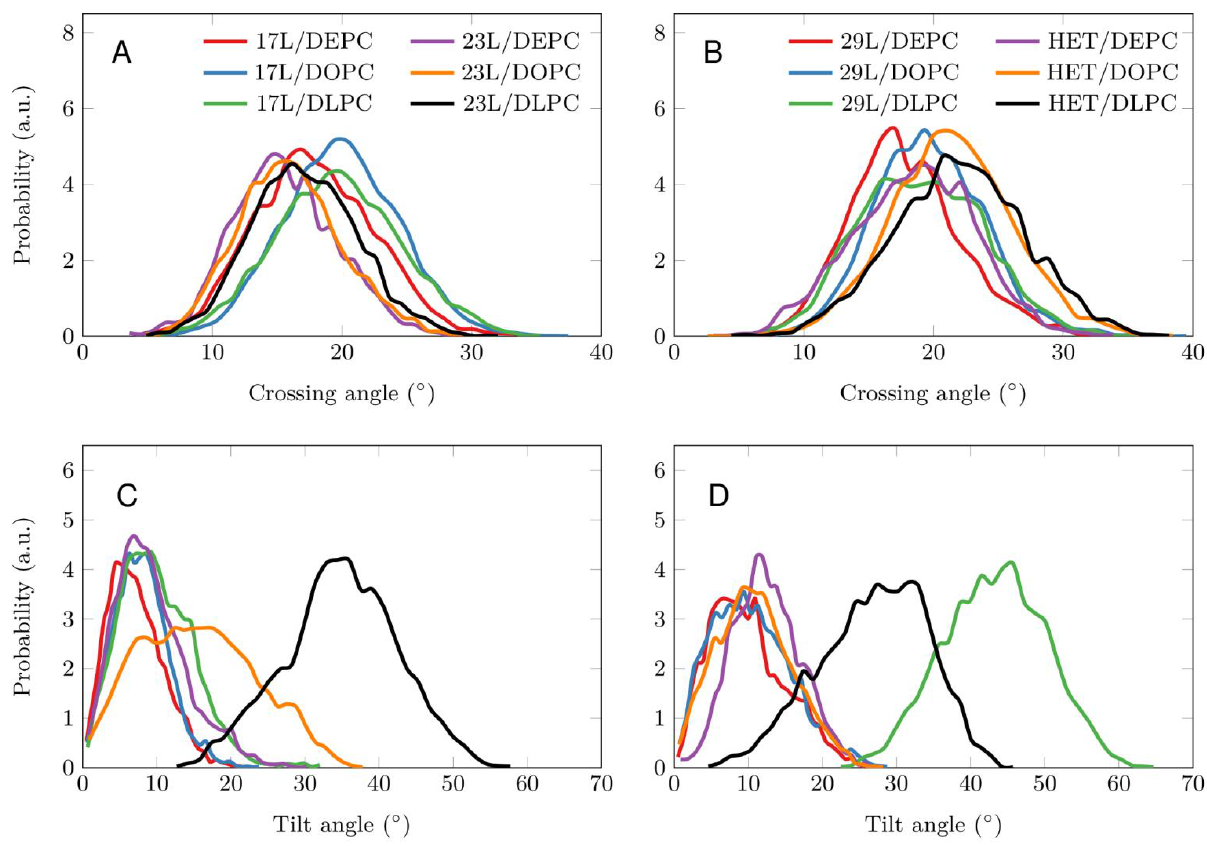
FIGURE 5: Tilt and crossing angle distribution. (A, B) Crossing angle distribution of the dimers calculated from the last 500 ns of the simulations. The 17L/29L hetero-dimer is labeled “HET”. (C-D) Tilt angle distribution of the dimers calculated from the last 500 ns of the simulations. The 17L/29L hetero-dimer is labeled